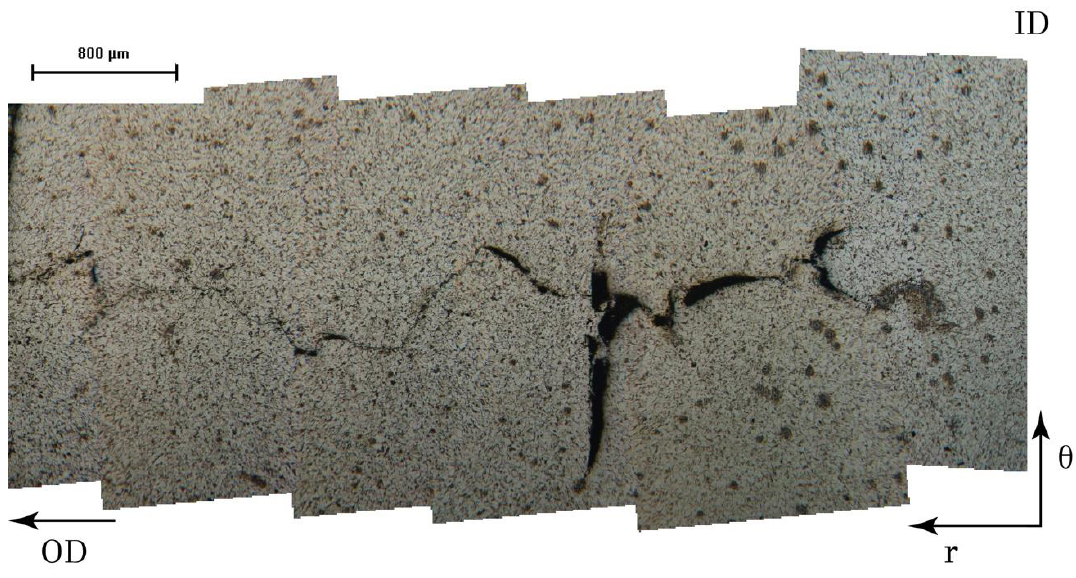
Figure 9. SOHIC at location 500.